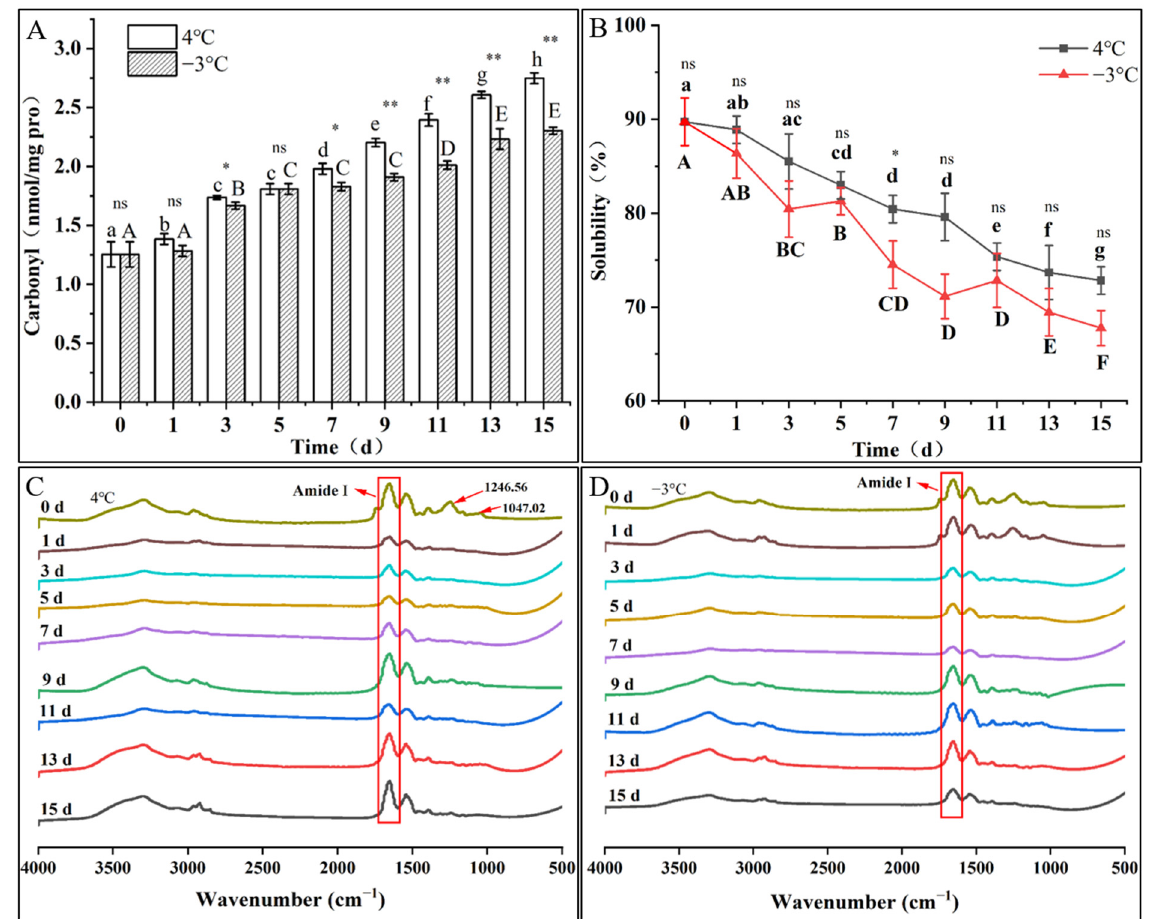
Figure 4. Myofibrillar proteins changes in carbonyl ( A ), solubility ( B ), and Fourier infrared spec- troscopy ( C , D ) during 4 °C refrigeration and − 3 °C super chilling storage for 15 d. Note: The different letters represent a significant difference between samples by storage time ( p < 0.05); different uppercase letters (A–F) indicate significant differences ( p < 0.05) for − 3 °C super chilling. Different lowercase letters (a–h) indicate significant differences ( p < 0.05) for 4 °C refrigeration. Significantly different as influenced by storage temperature: * ( p < 0.05); ** ( p < 0.01); ns: no significant difference ( p > 0.05). Specific numerical data about carbonyl and solubility are in the Supplementary Table S1.